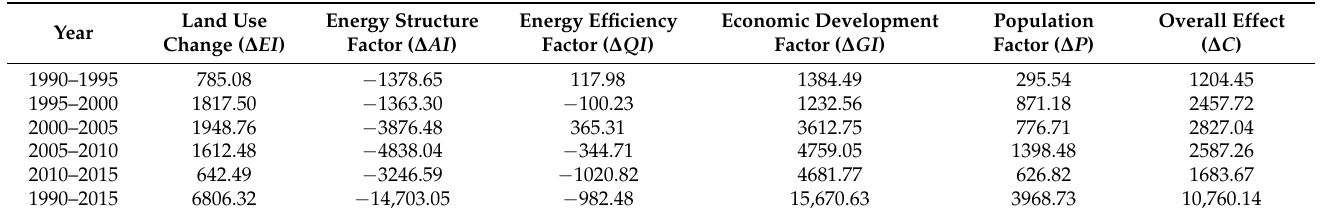
Table 5. The contribution value of each factor to land-use carbon emissions in the PRD (10 4 t C). Land Use Year Change ( ∆ EI